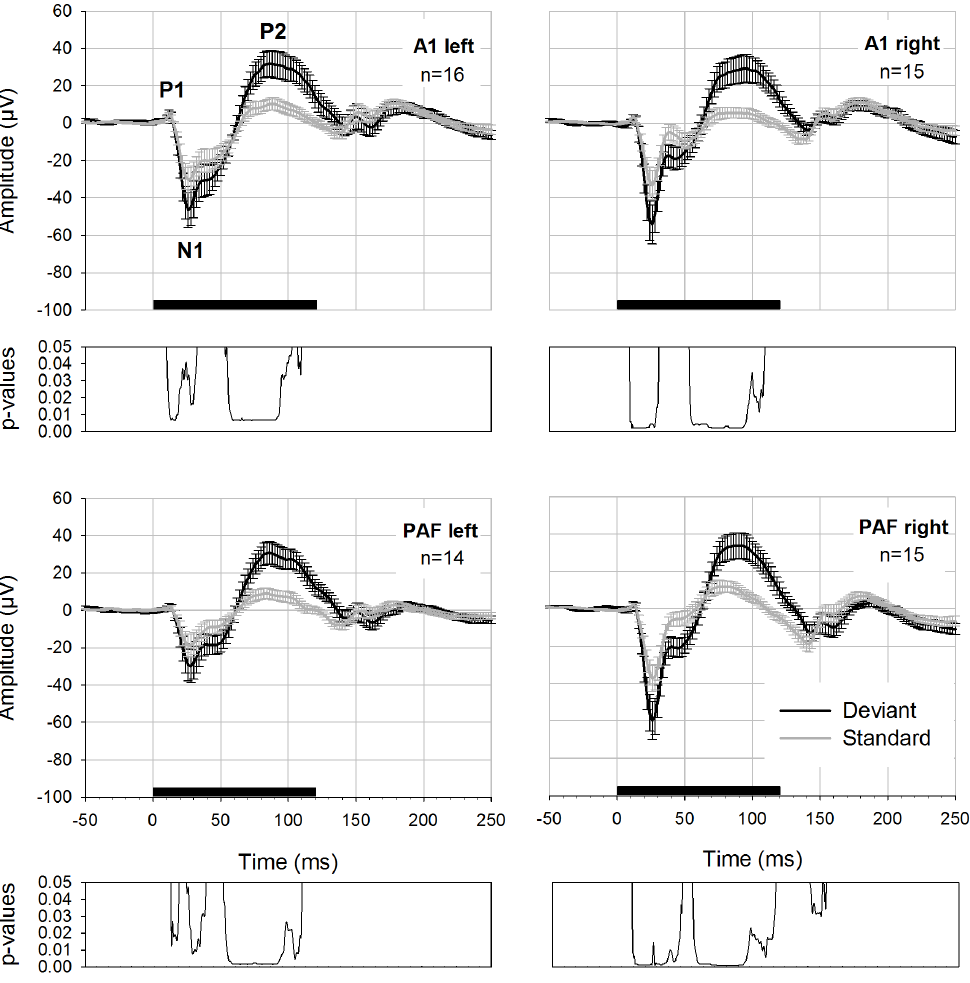
Figure 2. AEPs to deviant and standard stimuli elicited with a deviant probability of 0.2. Deviant (black curve) and standard potential (grey curve) with errorbars (standard error of the mean) displayed for four electrodes. Prominent peaks are labeled (P1, N1, P2). Black bar on the x-axis shows the stimulus duration. Below each graph FDR-corrected p-values are shown. doi:10.1371/journal.pone.0063203.g002 PLOS ONE |